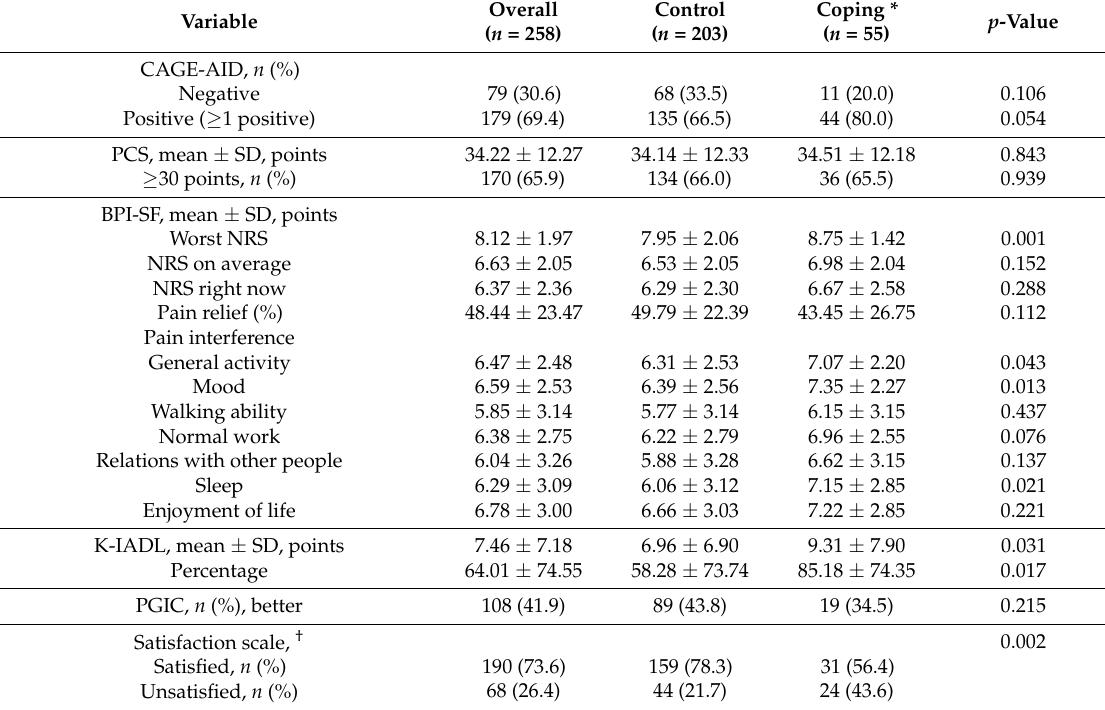
Table 4. Questionnaires and predictive